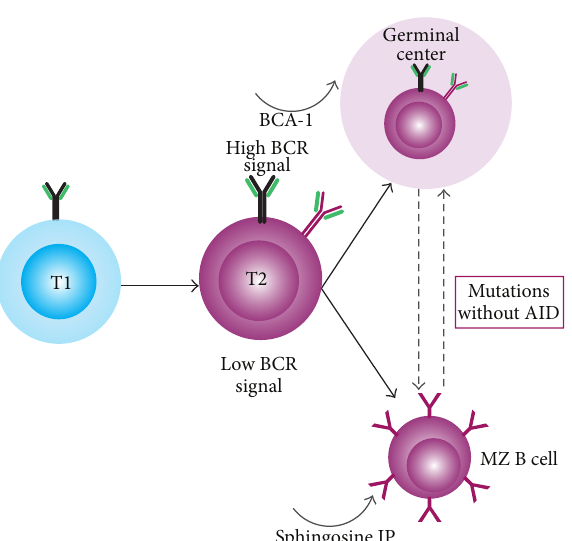
Figure 3: B cell classification based on their ontogenic state. From the transitional type 1 (T1) and T2 B cells, two options depend on theBcellreceptor(BCR)evokedsignalandthedownstreamNotch2 proteins: germinal center (GC) B cells driven by the B cell-attracting (BCA)-1 chemokine (or CXCL13) and MZ B cells with mutations but without activation-induced cytidine deaminase (AID). (Modified from